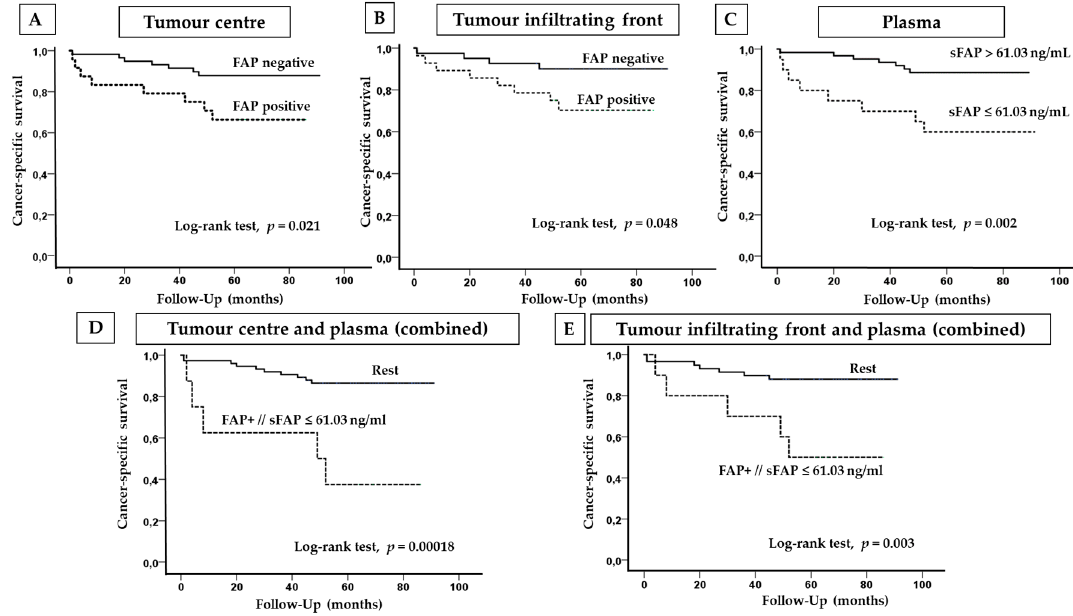
Figure Figure 4. Immunohistochemical FAP and plasma sFAP levels according to CCRCC patients’ cancer- specific survival (CSS). Kaplan–Meier curves and univariate log-rank test showed that FAP expression at tumour centre ( A ) and border ( B ) is associated to worse CSS. ( C ) CCRCC patients with lower sFAP levels than 61.03 ng/mL had worse CSS. Simultaneous expression of FAP at tumour centre ( D ) or border ( E ) and lower plasma FAP levels than 61.03 ng/mL are associated to worse CSS. Cut-off values of sFAP for CSS analyses were obtained by a Classification and Regression Tree (CRT) (Figure S2). A plasma sFAP value of 61.03 ng/mL determined two nodes with significant